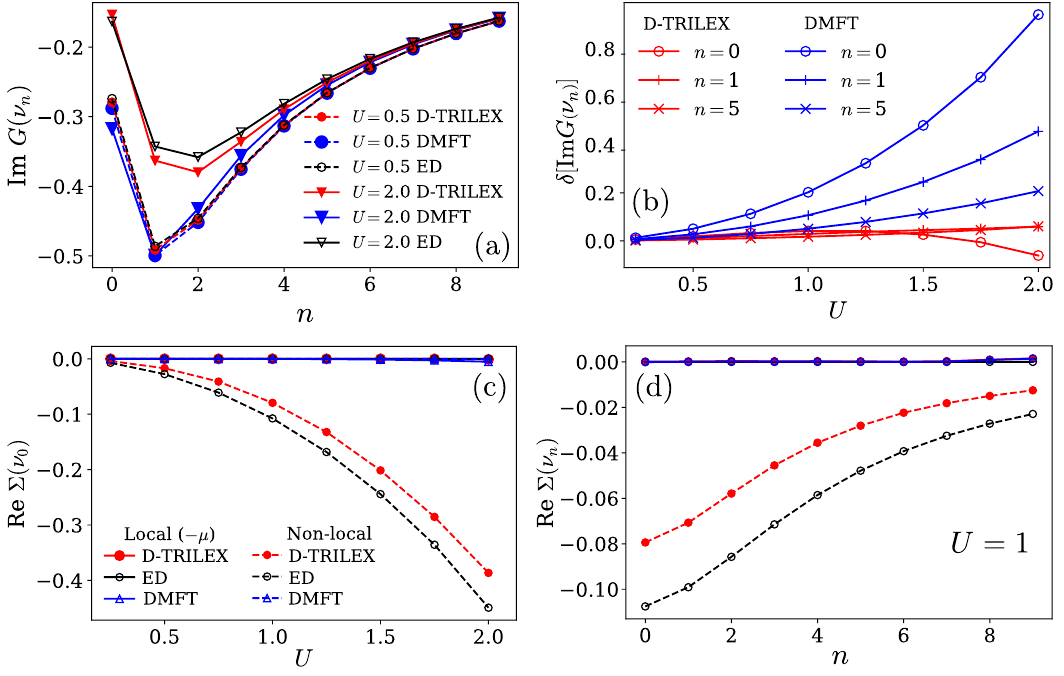
) calculated as a Figure 4: (a) Imaginary part of the local Green’s function Im G ( ν n function of the Mastubara frequency index n for two values of the interaction U = 0.5 (dashed lines) and U = 2.0 (solid lines). The result is obtained at half-filling for t = 0.5, β = 10, and J = U / 4 using the D-TRILEX (red), the DMFT (blue), and the )] (33) with respect to the ED (black) methods. (b) Normalized difference δ [ Im G ( ν n ED solution calculated for D-TRILEX (red), the DMFT (blue) methods as a function of U . The result is obtained for three difference Matsubara frequencies with indices n = 0 (empty circles), n = 1 (pluses), and n = 5 (crosses). (c) Real part of the self- energy Σ as a function of the interaction U at the first Matsubara frequency ν . (d) 0 ) as a function of the Matsubara index obtained Real part of the self-energy Σ ( ν n at U = 1. In panels (c) and (d), the local and non-local parts are shown and the chemical potential µ is subtracted from the local